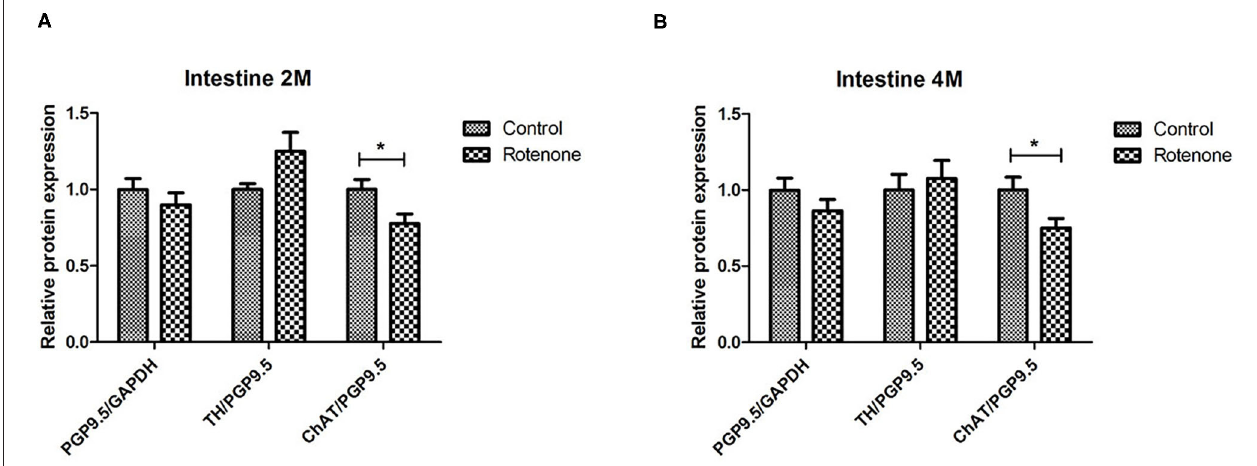
FIGURE 11 | Overall effect of 2- and 4-month rotenone exposure on the expression of ChAT, TH, and PGP9.5 in the gut. Bar graph in (A) shows the protein expression levels of ChAT, TH and PGP9.5 in control and 2 months rotenone-exposed mice as the average of the values obtained for all regions. Bar graph in (B) shows the protein expression levels of ChAT, TH and PGP9.5 in 4 months control and rotenone-exposed mice as the average of the values obtained for all regions. ChAT and TH were normalized to the total neuronal tissue, determined by PGP9.5 expression levels. PGP9.5 was normalized to GAPDH. Data was analyzed using a Student’s t -test (Mann-Whitney Test). *Corresponds to P < 0.05. n.s. non-significant. Error bars represent SEM in all